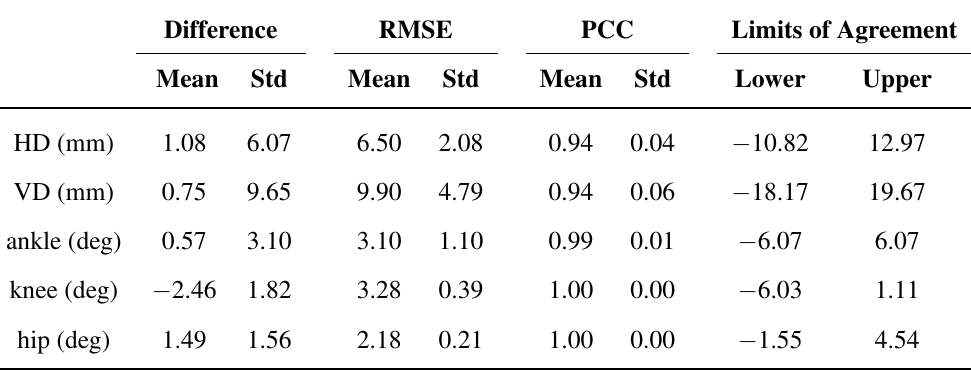
Table 3. Comparison of errors in measurements for the proposed and reference system. The mean difference and relevant standard deviation (std) together with Pearson’s correlation coefficient (PCC) values are shown. Bland–Altman limits of agreement are also reported. HD: Horizontal Displacement; VD: Vertical